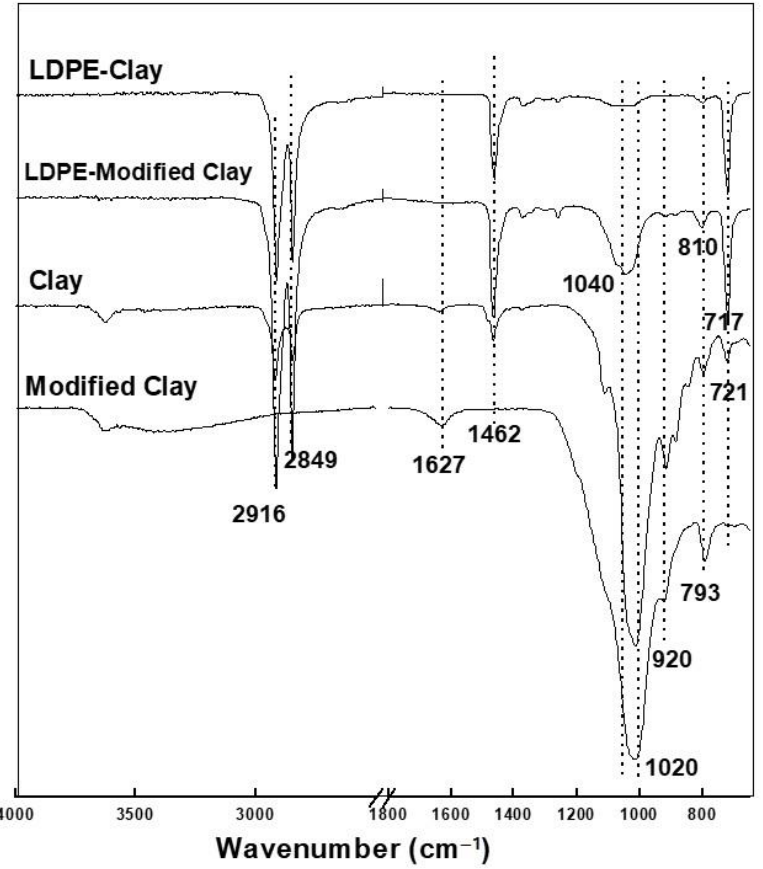
Figure 7 . FTIR spectrum of pure clay, pure modified clay, LDPE-Clay, and LDPE-modified